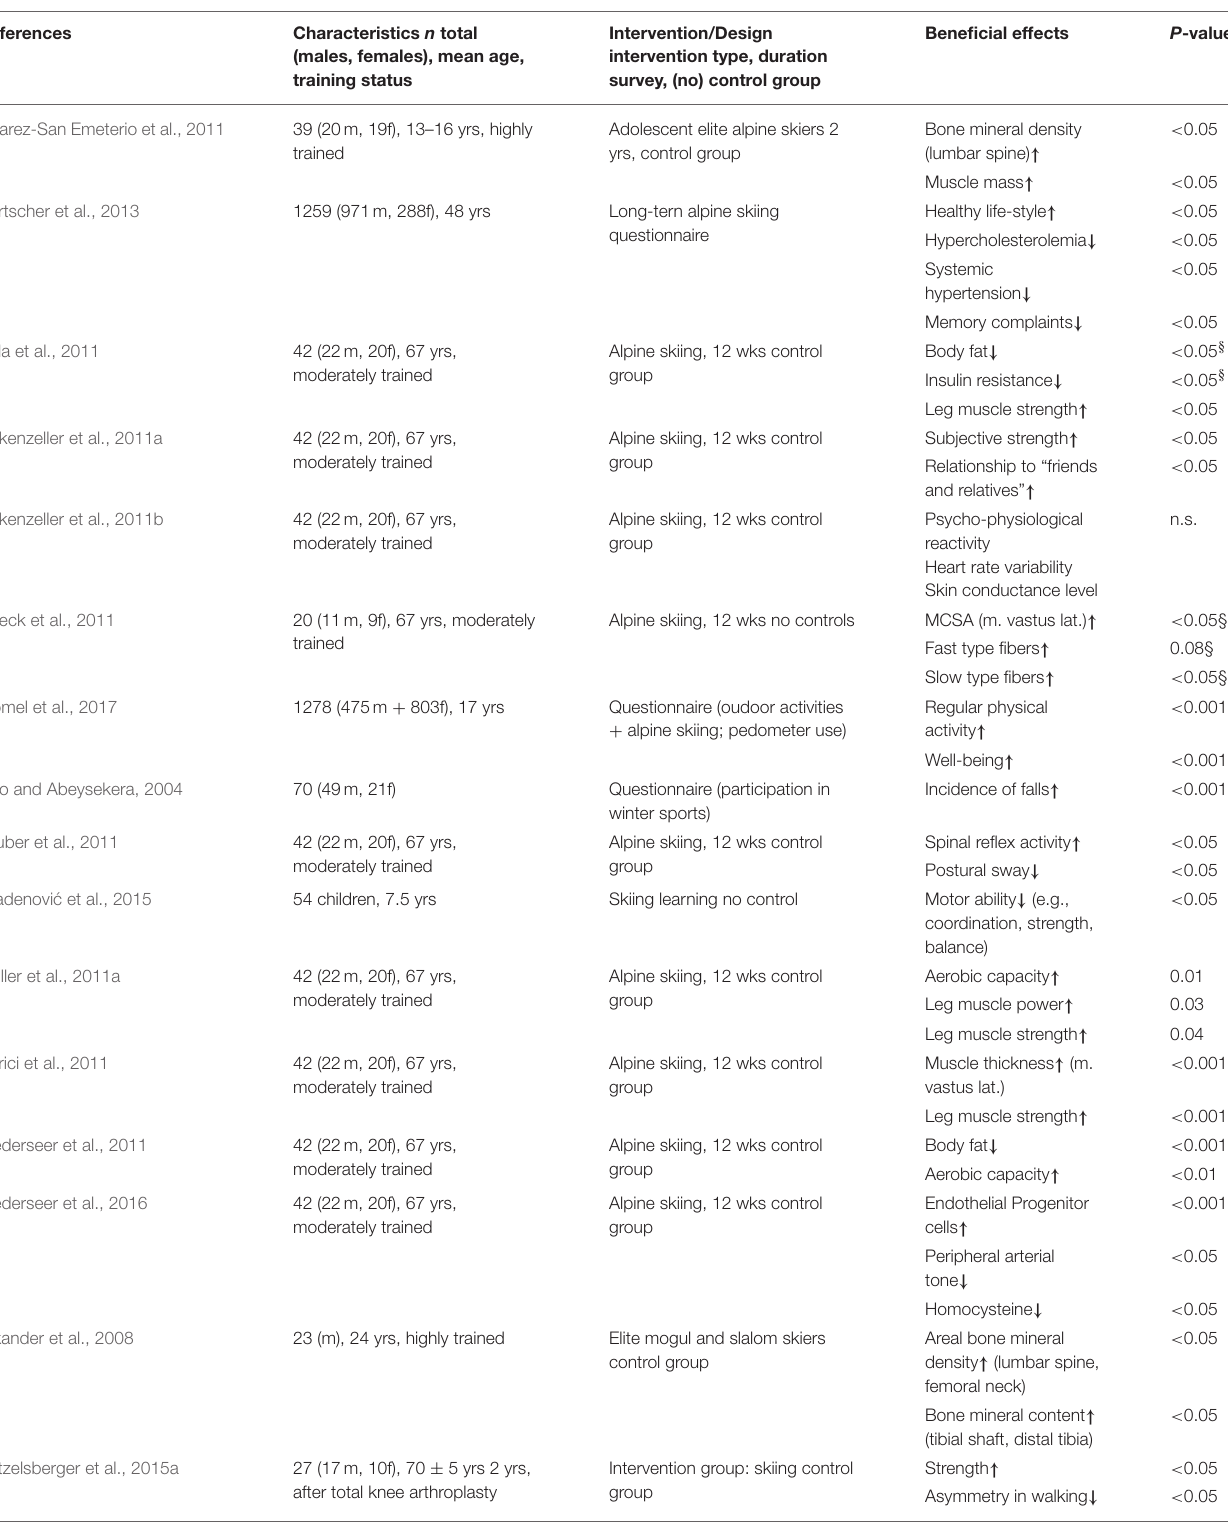
TABLE 1 | Characteristics of studies included for